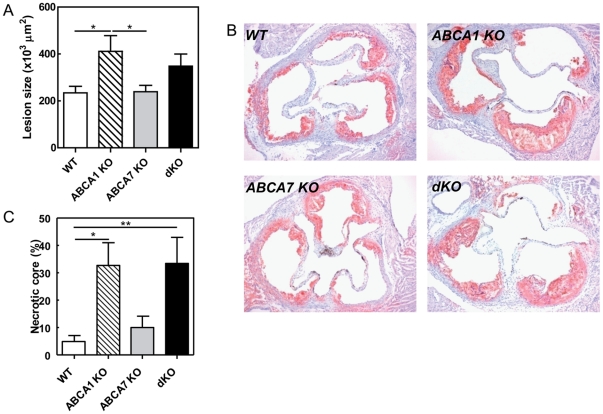
Atherosclerosis in the aortic root of LDLr KO mice reconstituted with WT, ABCA1 KO, ABCA7 KO and dKO bone marrow.(A) The mean lesion area (µm2) was calculated from Oil red O-stained cross-sections of the aortic root at the level of the tricuspid valves. (B) Representative pictures are shown. (C) The percentage of necrotic core of the total lesion was analysed using TUNEL staining. Values represent the mean±SEM of ≥6 mice per group. Statistically significant difference *p<0.05.